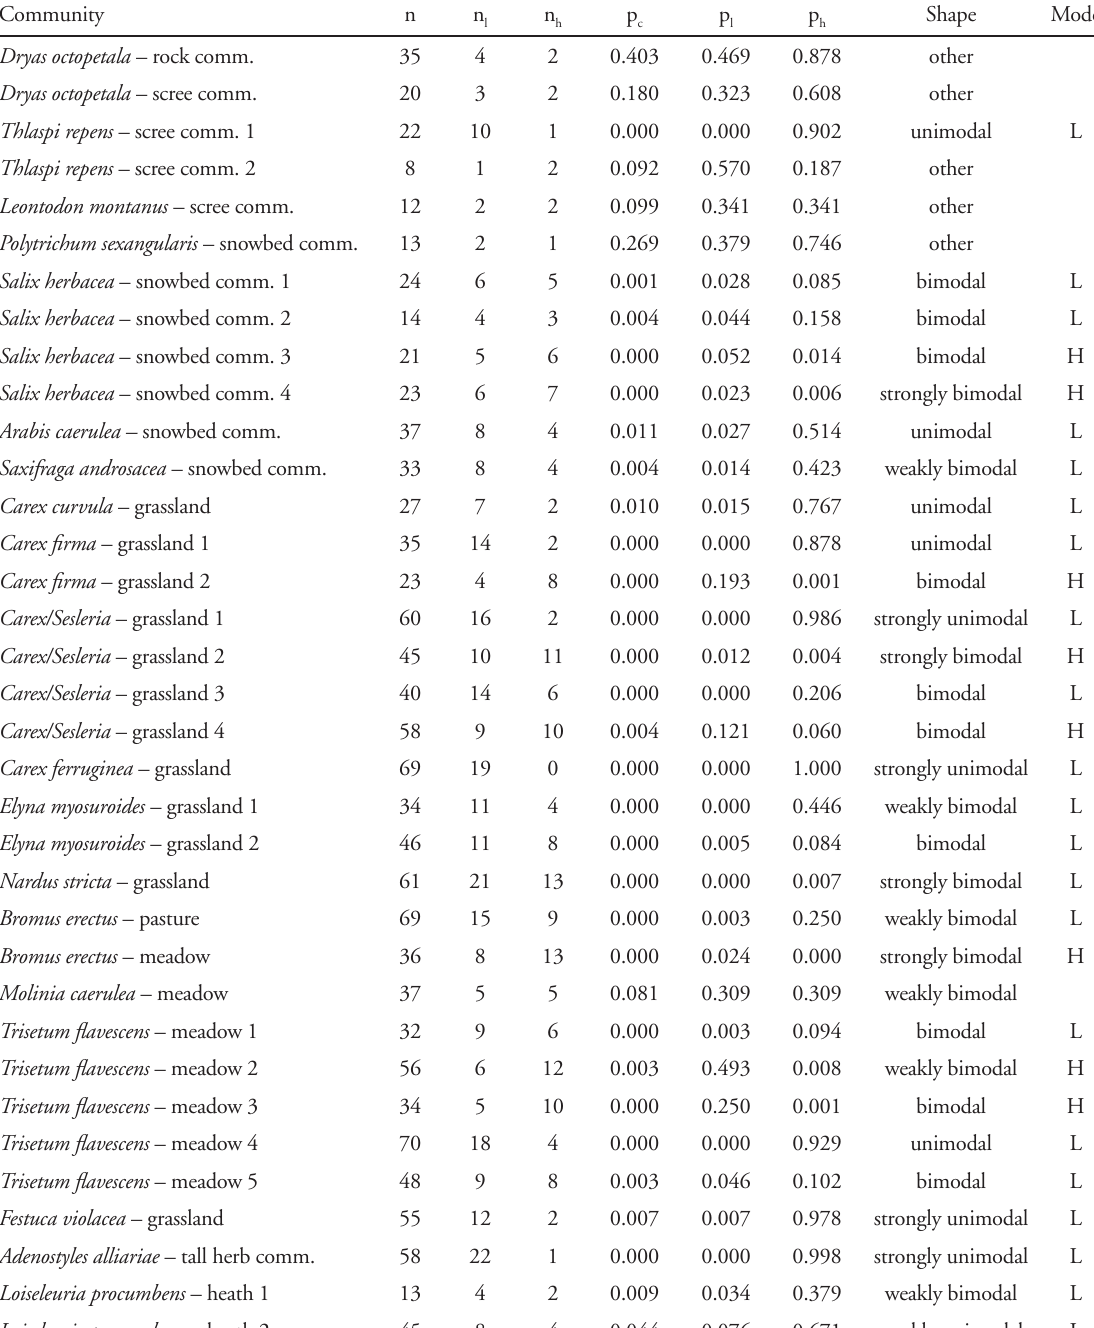
Table 2. Determination of the shape of the occupancy distributions and the significance of modes of 35 plant communities using the test procedure by Tokeshi (1992). Ten quadrats per community, quadrat size 1 m 2 . n = total number of species recorded in the ten plots; n = number of species in the satellite class, n = number of species in the core class; p = probability of obtaining the observed occupan- l h c cies of the satellite and core class combined; p = probability of obtaining the observed occupancy in the satellite class; p = probability l h of obtaining the observed occupancy in the core class; mode: largest mode in the satellite (L) or in the core class (H),